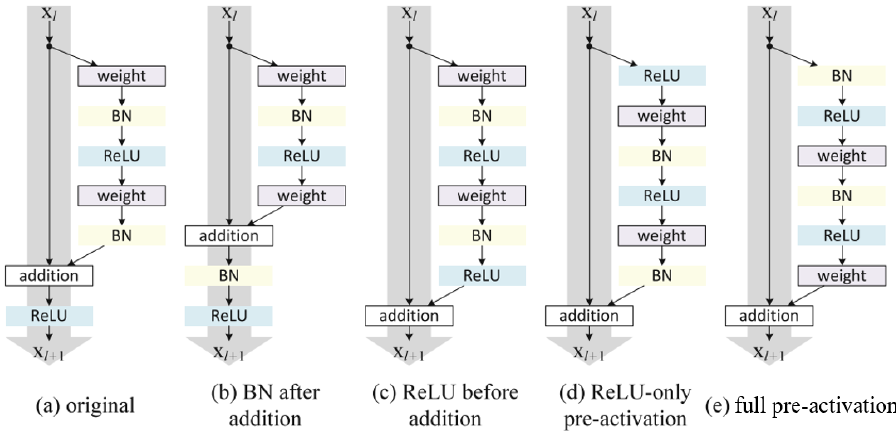
Figure 2. Some variants of the residual block.